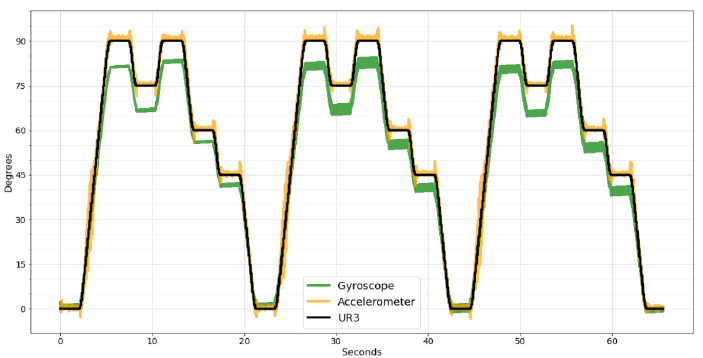
Figure 10. Wearable system raw data synchronized with UR3 data.